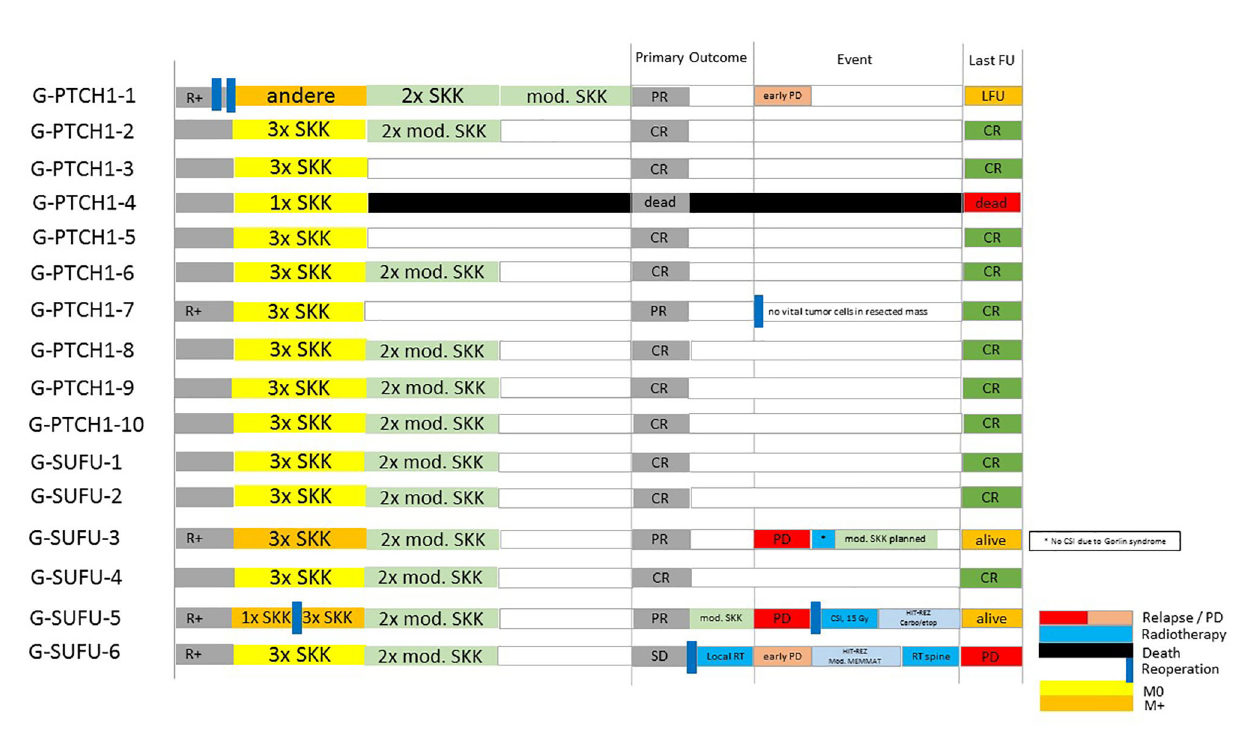
FIGURE 2 | Clinical courses of patients from the Gorlin cohort.